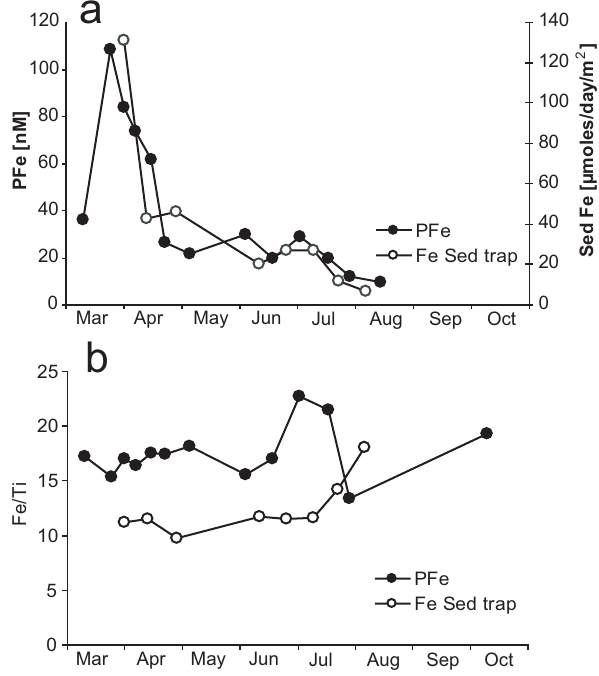
Fig. 10. Suspended Fe (PFe) at 5 m depth and sediment trap col- lected Fe at 30 m depth at Landsort Deep (BY31) 2004 (a) . Fe/Ti in PFe at 5m depth and in sediment trap collected material (b)